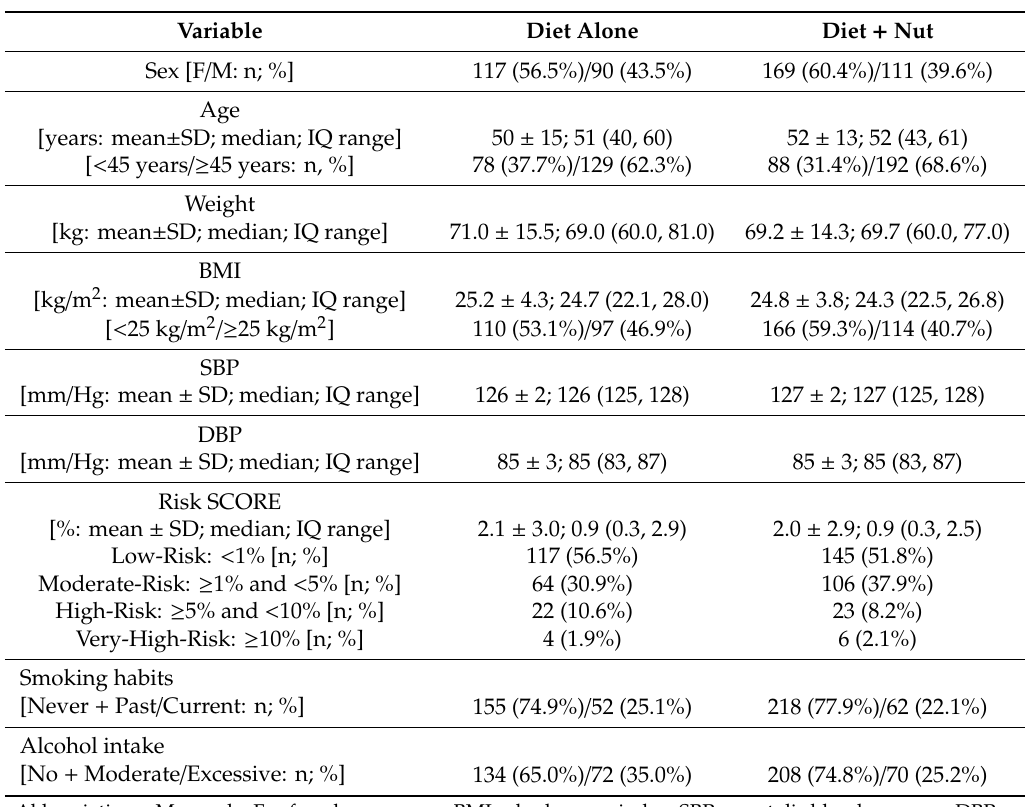
Table 1. Baseline characteristics of 487 dyslipidemic non-statin treated patients divided in diet alone and diet plus NUT